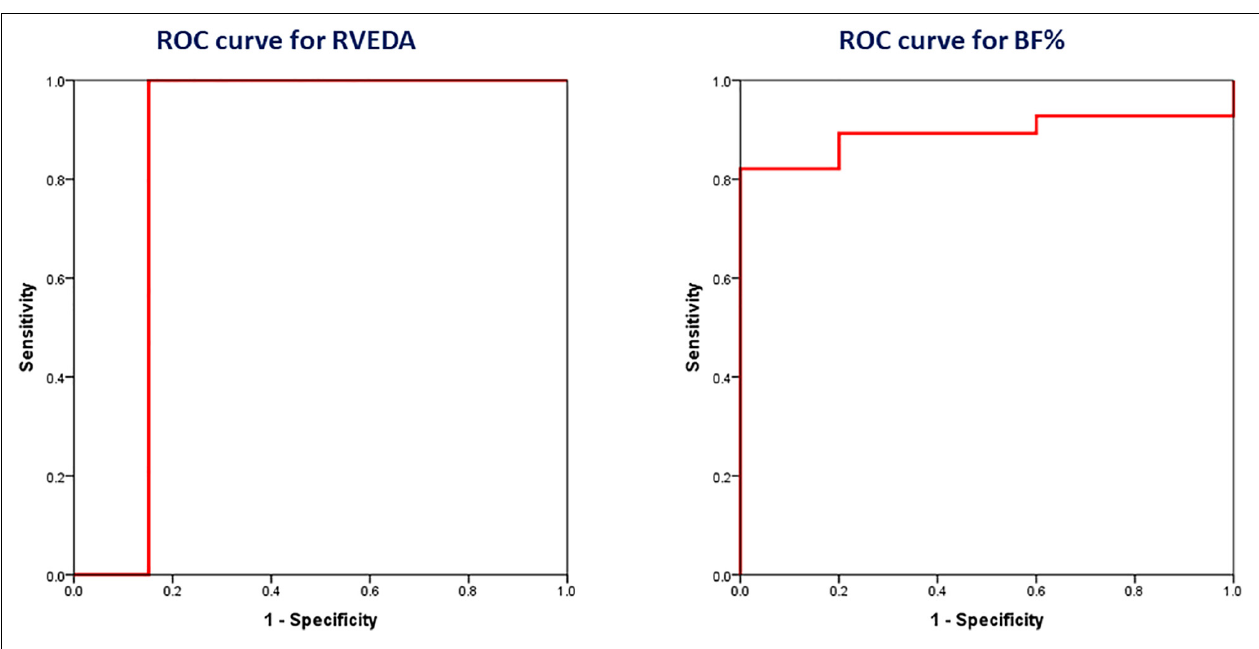
FIGURE 6 | Receiver-operating characteristic (ROC) curves showing the ability of right ventricular end-diastolic area (RVEDA) [ n = 45 (36 males, 9 females)] and body fat percentage (BF%) [ n = 33 (27 males, 6 females)] to discriminate between athletes with marathon race time (MRT) < 3:00:00 and the ones with MRT ≥